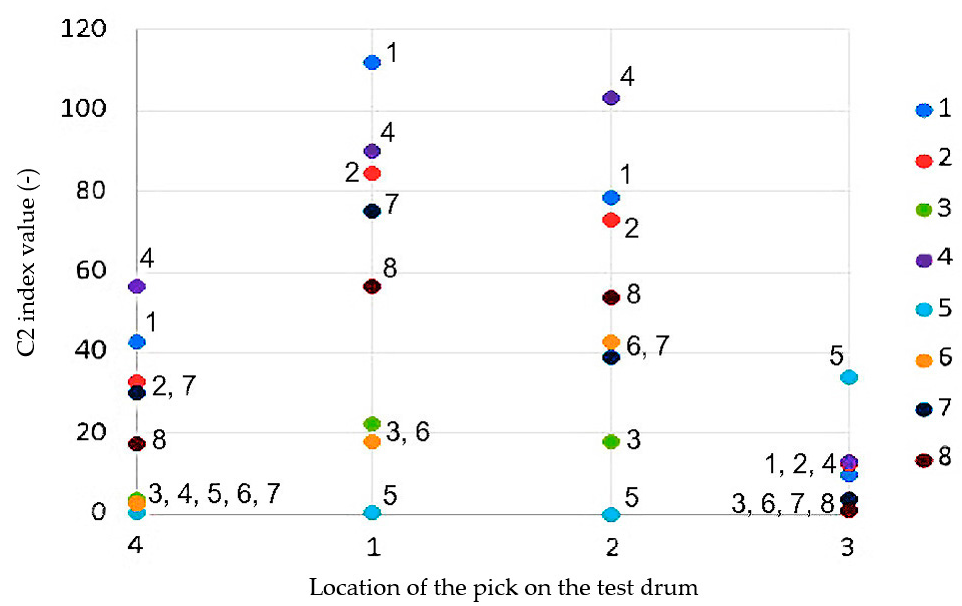
Figure 16. C 2 index values for individual picks and their locations on the test drum.